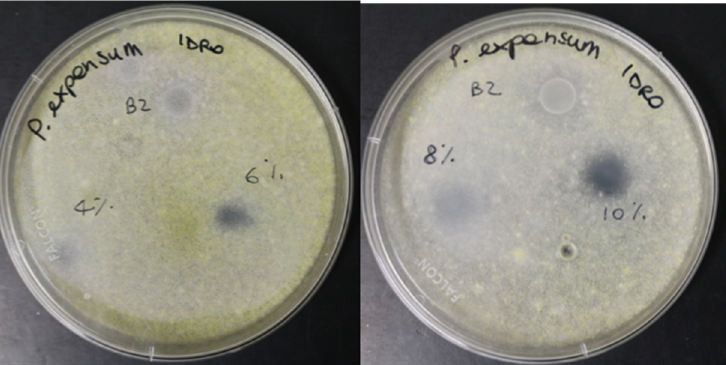
Figure 5. Mycelial growth inhibition of lemon grass essential oil dispersed in water at different concentrations (4, 6, 8, 10%) against Penicillium expansum after 9 days of incubation at 25 °C. B2 = control spot containing alginate/Tween 80.